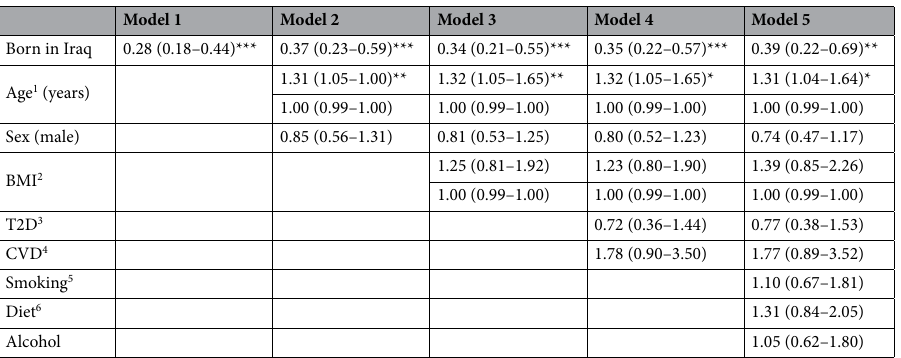
Table 3. Cox regression models showing adjusted HR of cancer events and death from cancer, Model 1–5, 95.0% CI for Exp(B). 1 Linear age and age squared, 2 linear BMI and BMI squared, 3 T2D at baseline, 4 CVD at baseline, 5 current tobacco smoking, 6 daily intake of fruit, berries and/or vegetables, p < 0.05*, p < 0.01**, p < 0.001***.